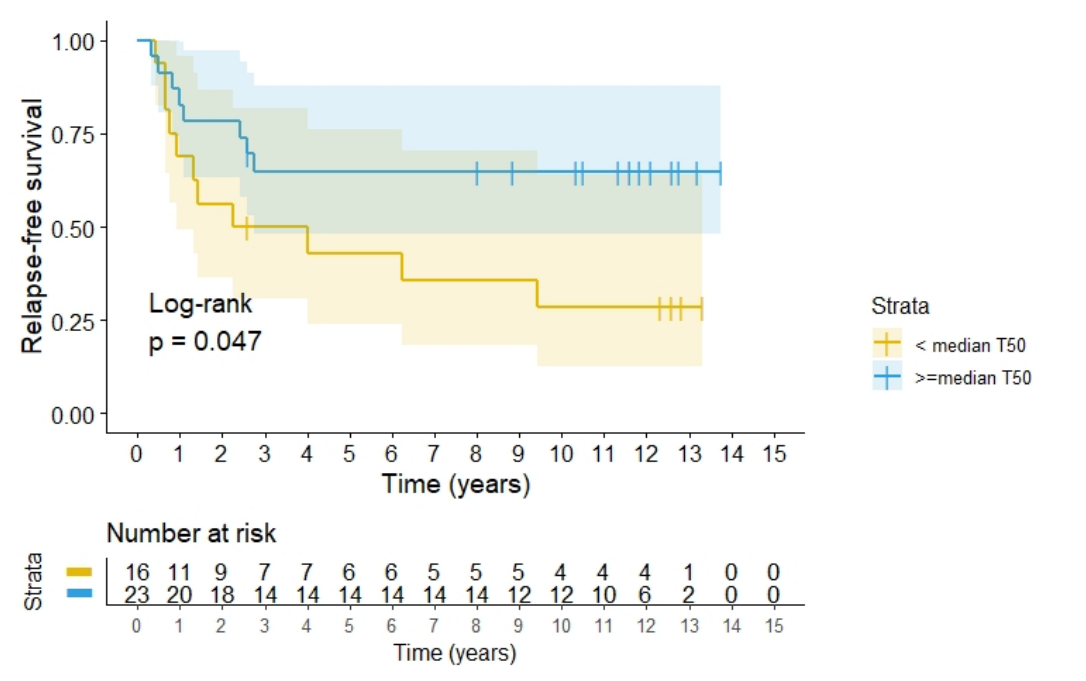
Figure 5. RFS according to quality of heating divided above or below 39.91 ◦ C, the median of the T50 measured in the tumours during all heating sessions among 39 patients.